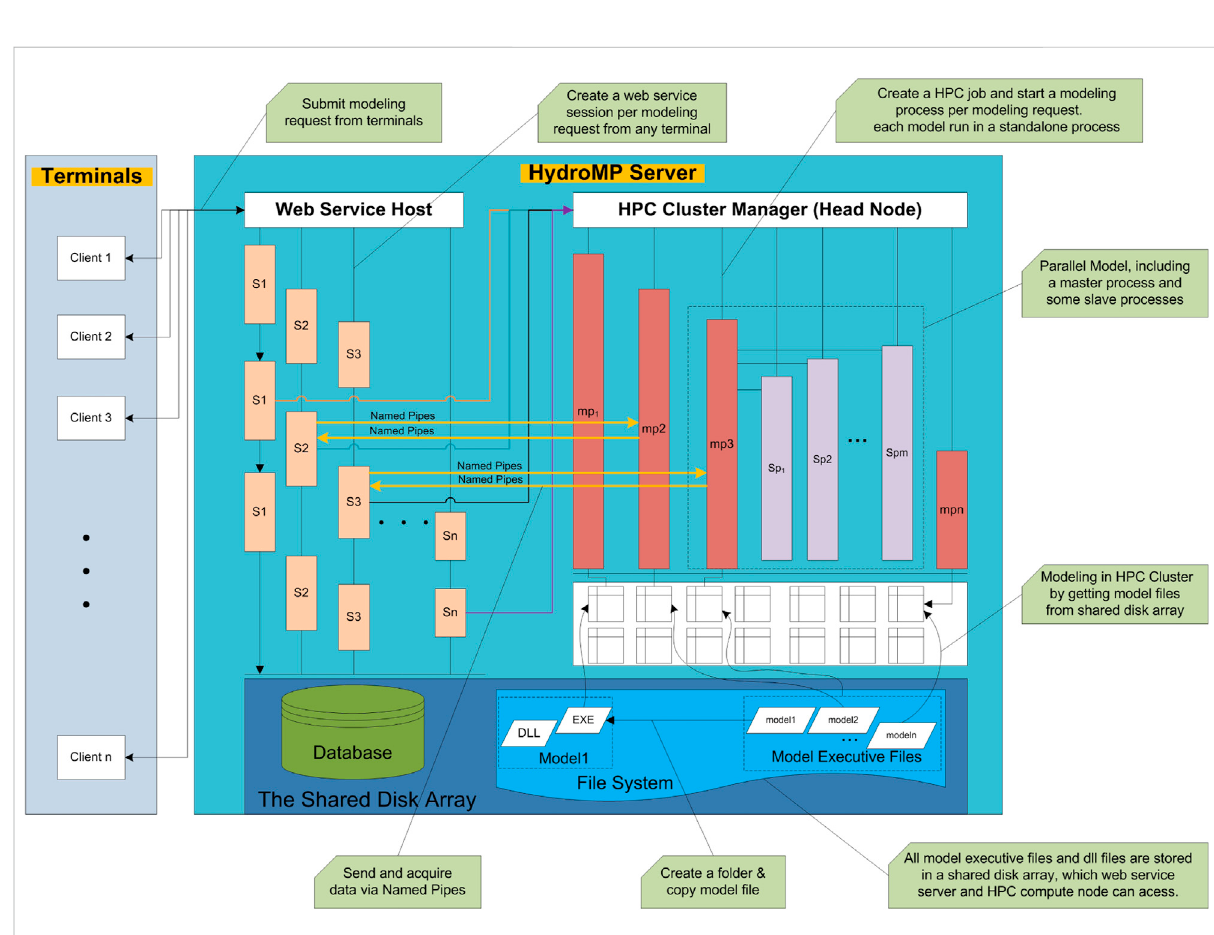
FIGURE 2 Logical hierarchy of the platform and model process in cloud computing